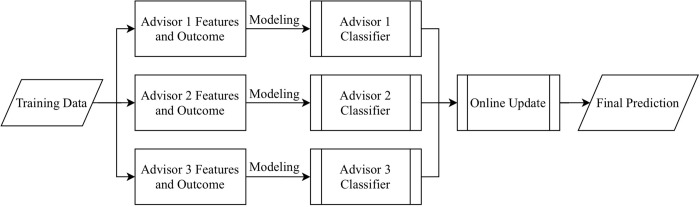
Overview of dynABE.